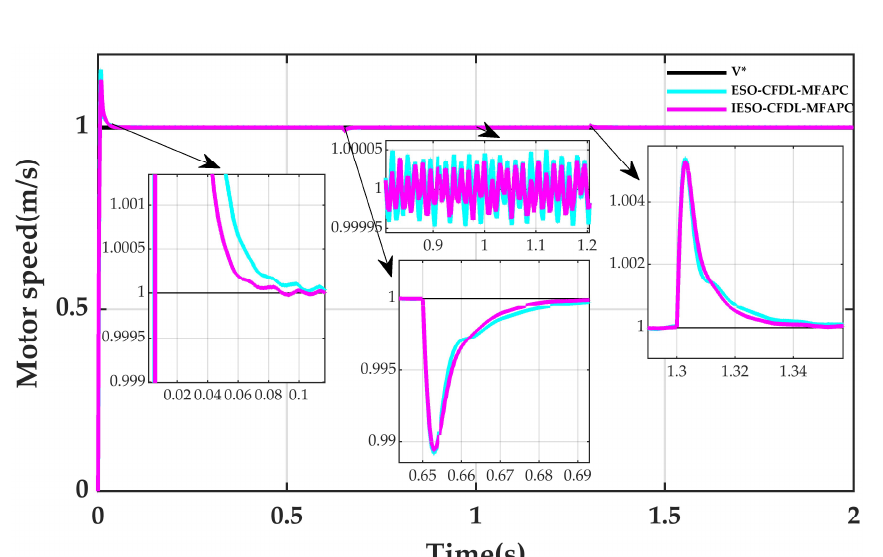
Figure 7. Speed comparison before and after ESO improvement.